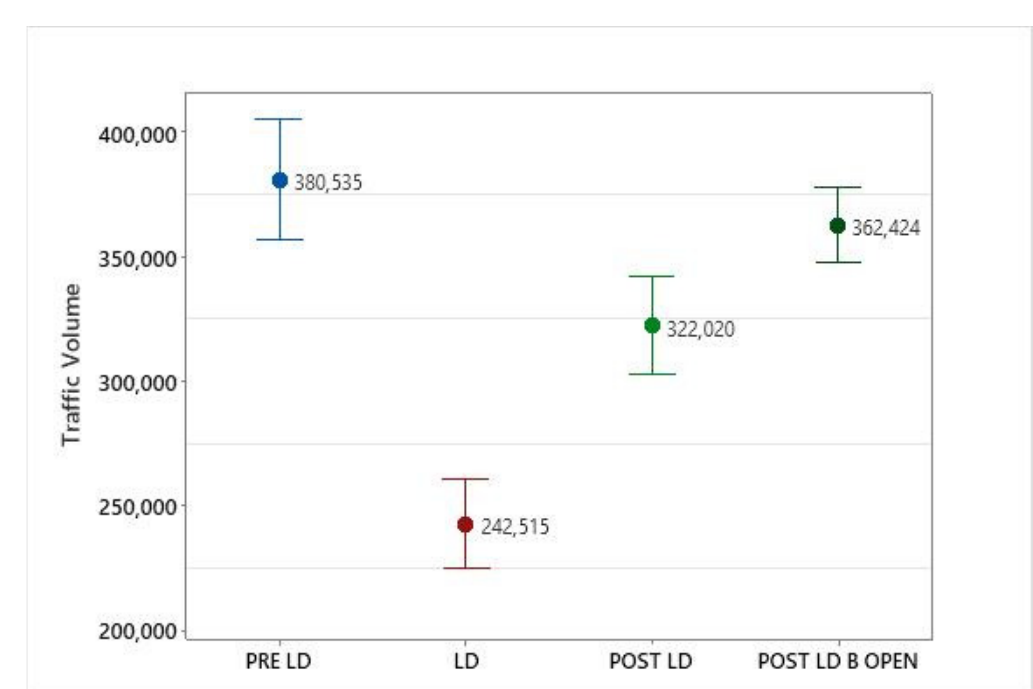
Figure 8. Change in traffic volumes before, during, and after the lockdown period. Error bars represent 95% confidence interval of the mean. Abbreviations: PRE LD: Pre-lockdown, LD: Lockdown, POST LD: Post-lockdown and POST LD_B OPEN: Post-lockdown—businesses.